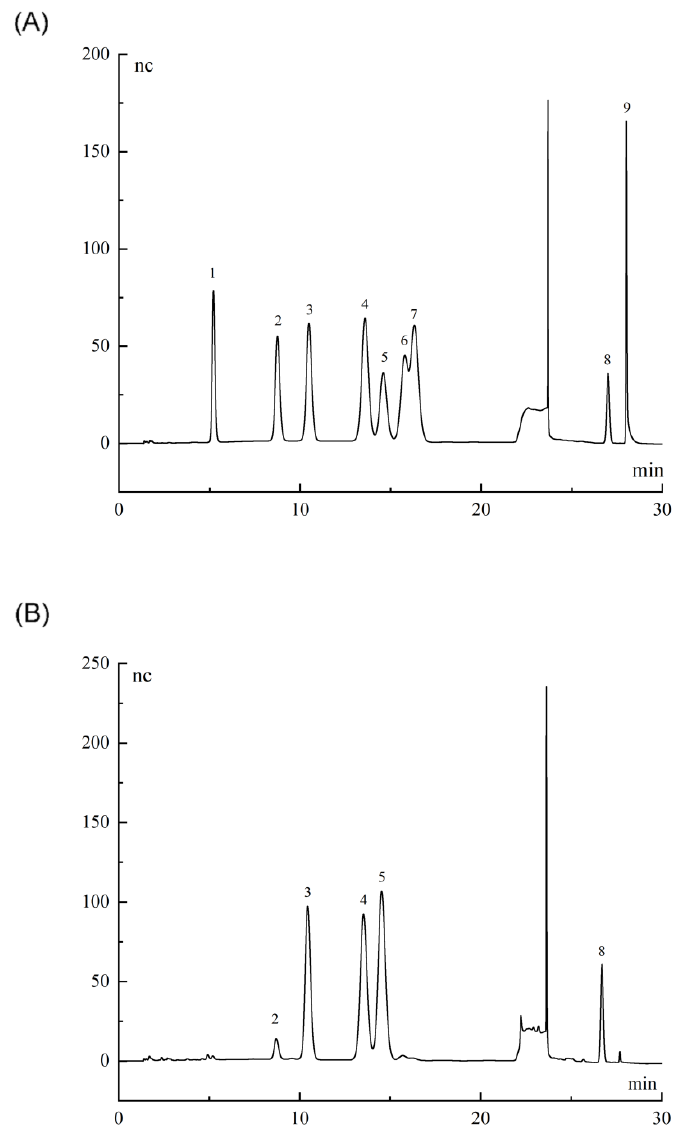
Figure 6. ( A ) Ion chromatogram of standard monosaccharide; ( B ) Ion chromatogram of BCP monosaccharide. (1) Fucose (Fuc); (2) Rhamnose (Rha); (3) Arabinose (Ara); (4) Galactose (Gal); (5) Glucose (Glu); (6) Xylose (Xyl);(7) Mannose (Man); (8) Galacturonic acid (GalA); (9) Glucuronic acid (GluA).